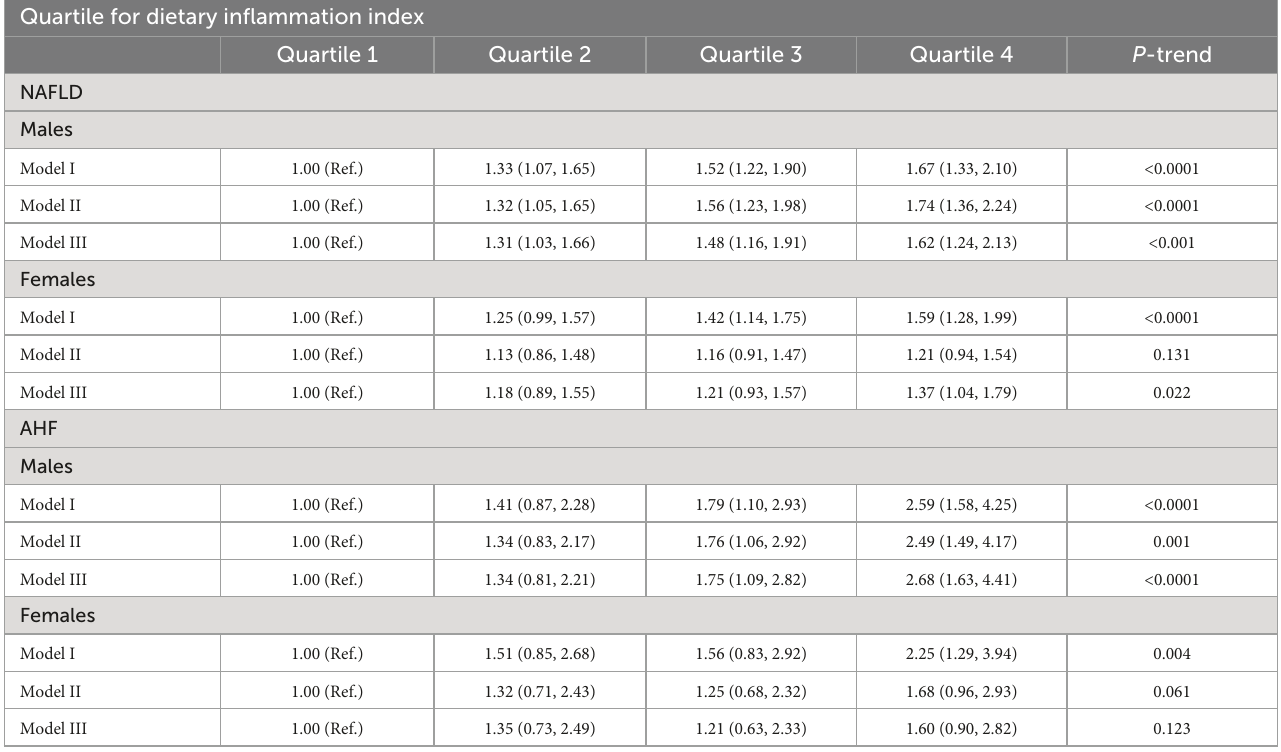
TABLE 3 Survey weighted odds ratio (95% CI) for association between dietary inflammatory index (DII) and the presence of non-alcoholic fatty liver disease (NAFLD) and advanced hepatic fibrosis (AHF) stratified by sex in the 2005–2016 continuous National Health and Nutrition Examination Survey (NHANES). Quartile for dietary inflammation index